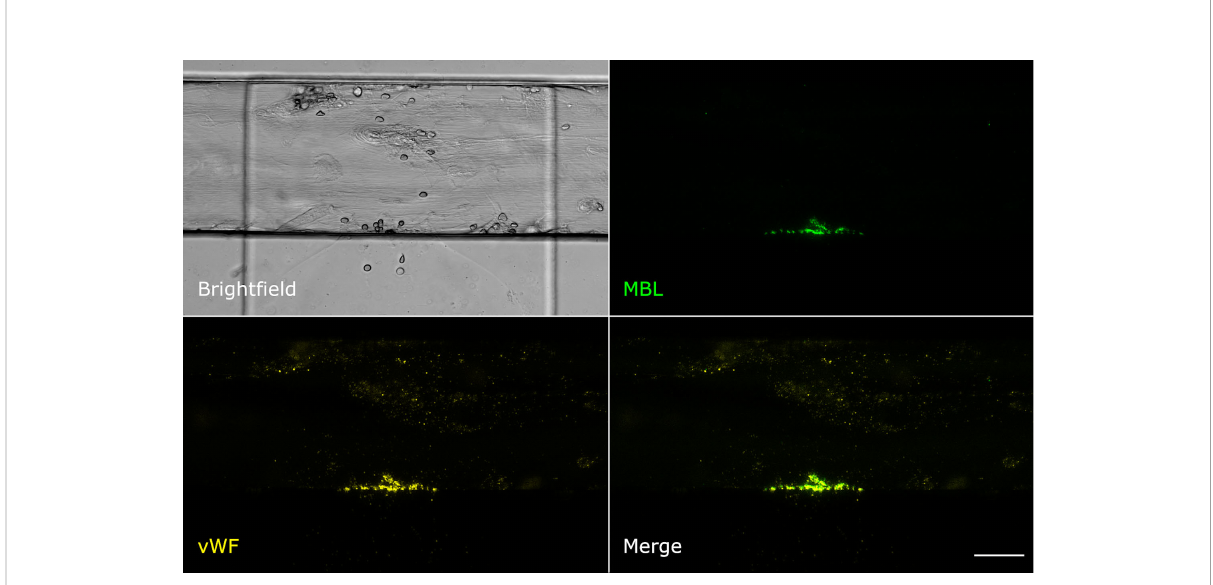
FIGURE 4 MBL colocalises with von Willebrand factor. Micro fl uidic bleeding model 45 min after injury. From top left to bottom right: Bright fi eld, anti-MBL signal (green), anti-von Willebrand factor signal (yellow), and merged signals. MBL and von Willebrand factor showed strong colocalisation. Scale bar: 50 µm.